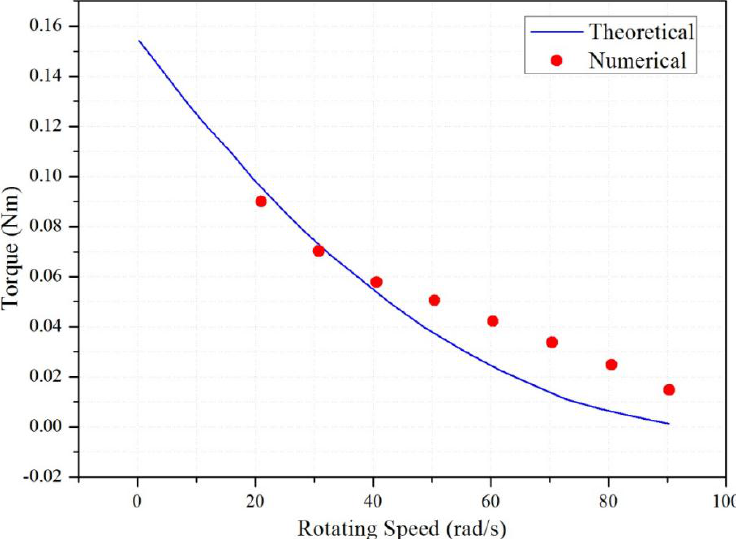
Figure 7. Comparison of the theoretical prediction with the numerical results (U = 5